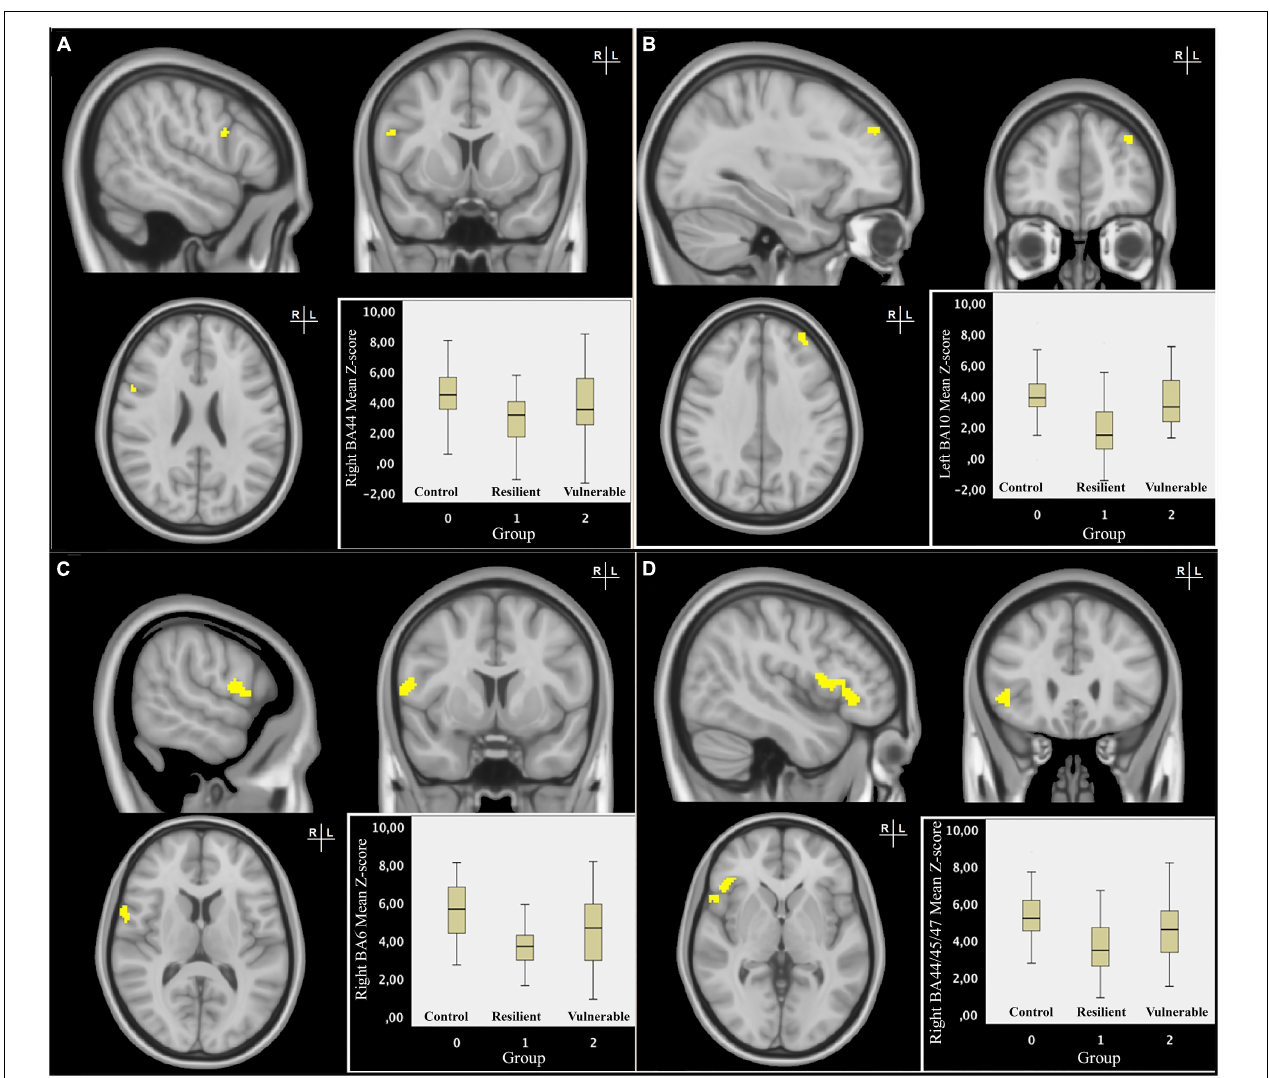
FIGURE 2 | Resilience-specific resting-state functional connectivity (RSFC) of the salience network (SN). Coronal, sagittal and transversal slices of the MNI-152 0.5 mm standard brain. The RES group showed significant differential RSFC of the right BA44 (A) and left BA10 (B) with the salience network compared to the VUL and CON group. The significant clusters were threshold at p < 0.05 and subsequently binarized in a mask. The boxplot displays mean individual z-scores of these clusters, depicted separately for each group. In radiological convention, the right side of the image corresponds to the left side of the brain. Coronal, sagittal, and transversal slices of the MNI-152 0.5 mm standard brain. The RES group showed significant differential RSFC of the right BA6 (C) and right BA44/45/47 (D) with the salience network compared to the VUL and CON groups. The significant clusters were threshold at p < 0.05 and subsequently binarized in a mask. The boxplot displays mean individual z-scores of these clusters, depicted separately for each group. In radiological convention, the right side of the image corresponds to the left side of the brain.